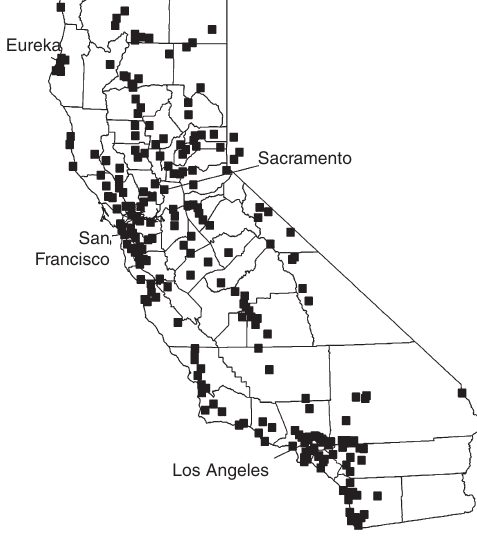
Fig. 2b. Locations of newspapers in print, 1880- 1889 (modified from Toppozada et al. , 1981).